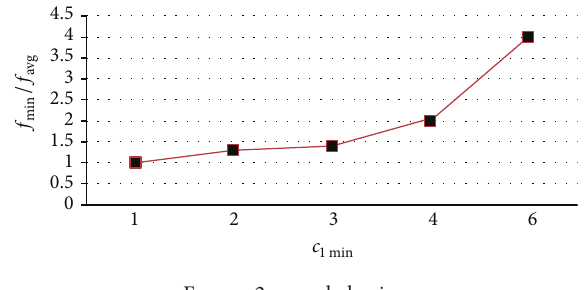
Figure 2: 𝑐 1 min